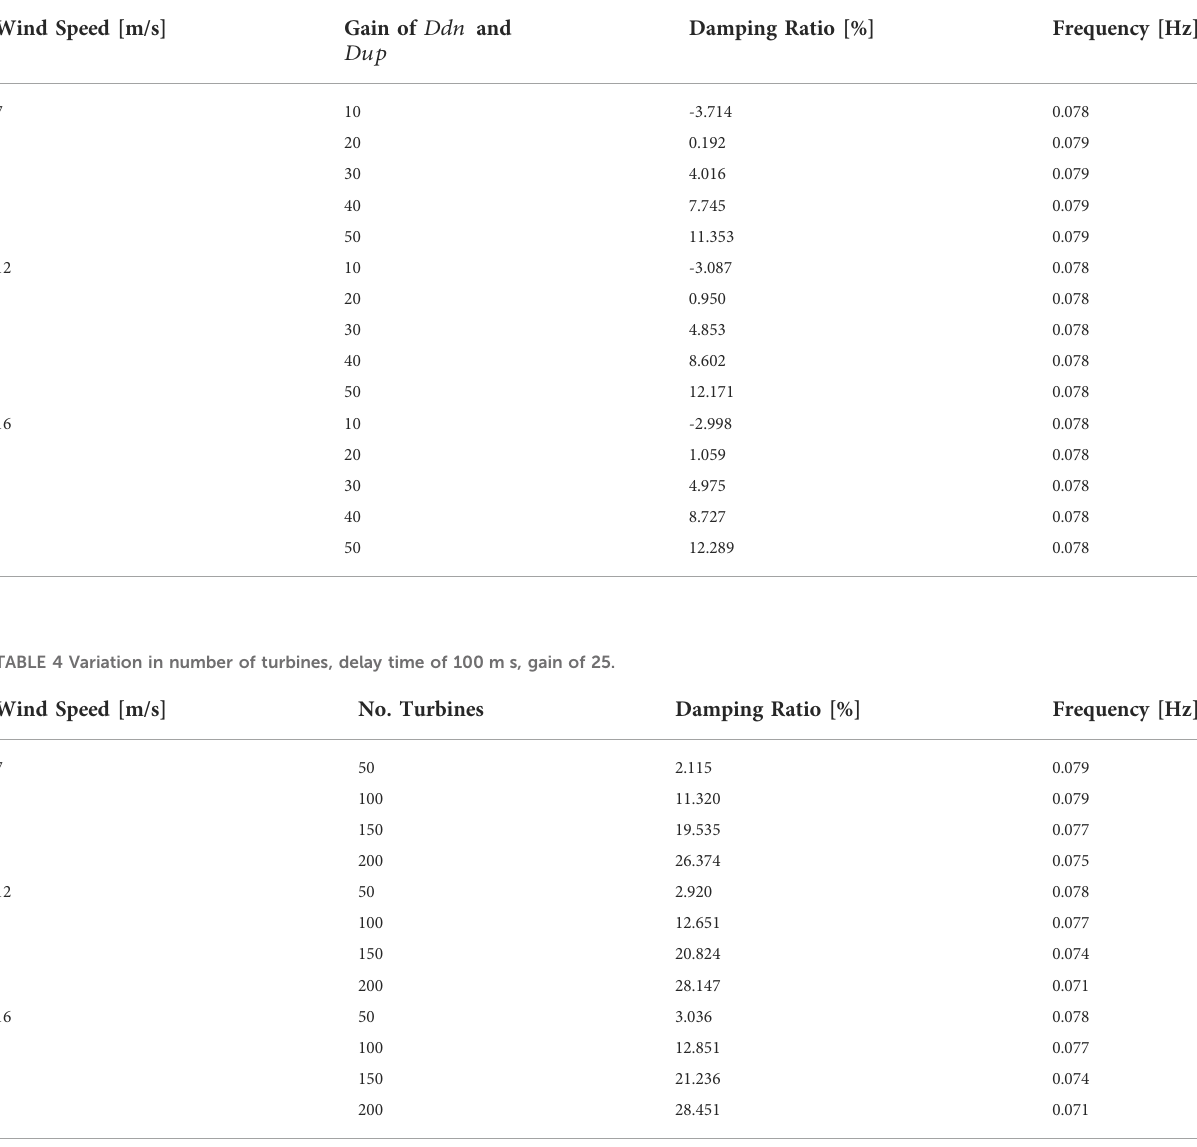
TABLE 3 Variation in grain/droop, delay time of 100 m s.